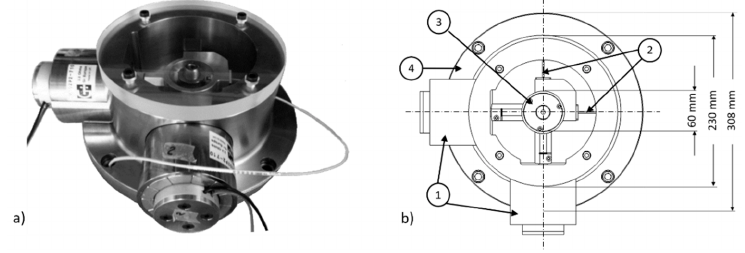
Damper support. (4) Body of the machine. Figure 2. ( a ) Picture of the machine. ( b ) View from top. (1) Actuators. (2) Displacement sensors. (3)